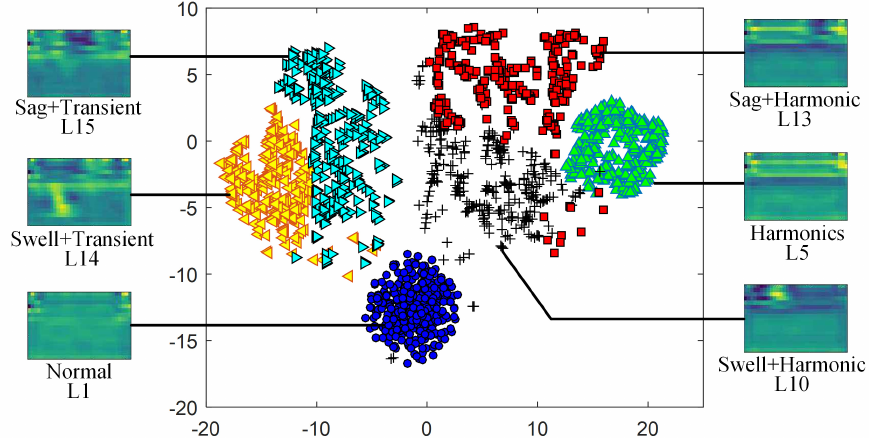
Figure 8. Visualization of PQD features z 3